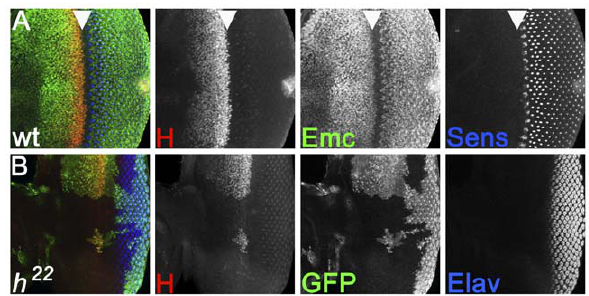
Figure 2. Da, Emc and Hairy expression are independent of hairy . Clones of homozygous mutant cells are labeled by the lack of GFP expression (green). (A) In h 22 mutant clones, Da expression (magenta) both inside and outside of the furrow remained unaffected. (B) In h 22 mutant clones, Emc expression (magenta) both inside and outside of the furrow remained unaffected. (C) In h 22 mutant clones, Ato expression (magenta) was unaffected. (D) Cell-autonomous high Da expression (magenta) in emc AP6 h 22 double mutant cells. Note the very similar levels of Da in emc AP6 h 22 double mutant cells and emc AP6 mutant cells (compare panel E). (E) Cell-autonomous high Da expression (magenta) in emc AP6 mutant cells. Note the very similar levels of Da in emc AP6 mutant cells and emc AP6 h 22 double mutant cells (compare panel D). Genotype : (A–C) ywhsF; h 22 FRT80/[ Ubi-GFP ] M (3)67 C FRT80; (D) ywhsF; emc AP6 h 22 FRT80/[ Ubi-GFP ] M (3)67 C FRT80; (E) ywhsF; emc AP6 FRT80/[ Ubi-GFP ] M (3)67 C FRT80.